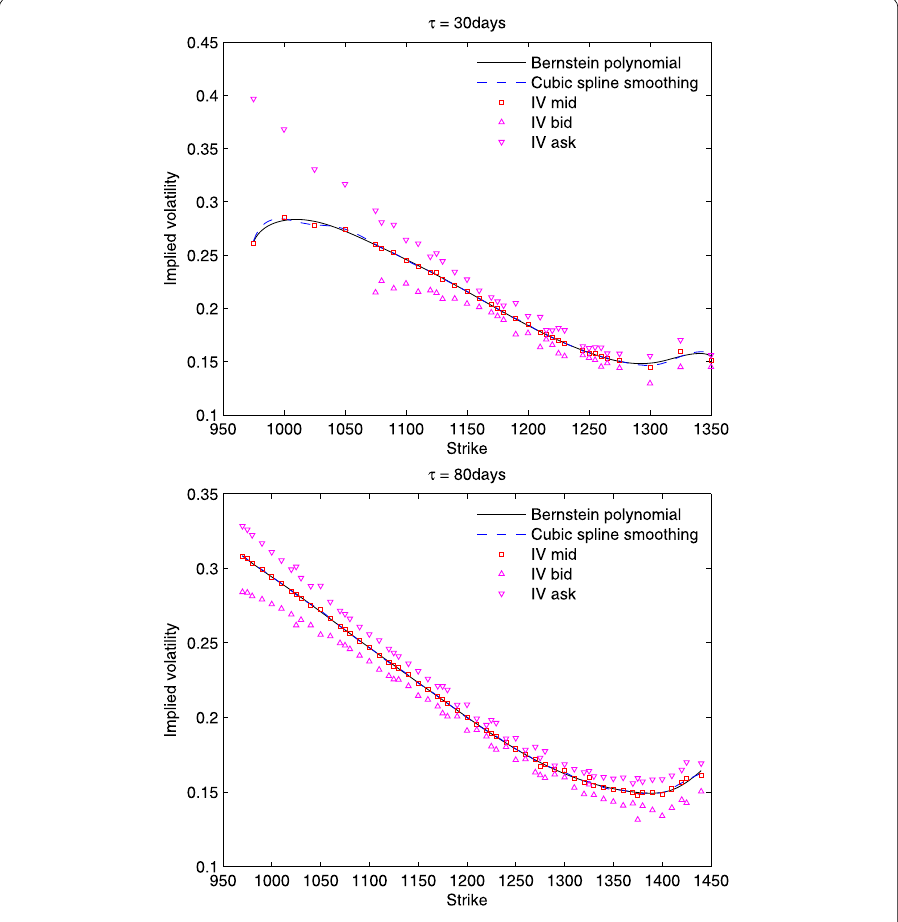
Figure 4 Comparison of the implied volatility curve estimated from the Bernstein polynomial (BP) estimator and the Cubic spline smoothing method. IV mid, IV bid and IV ask are computed from the corresponding mid price, bid price and ask price by inverting equation (28). Results are reported for both of the times to maturity of τ = 30 days and τ = 80 days,